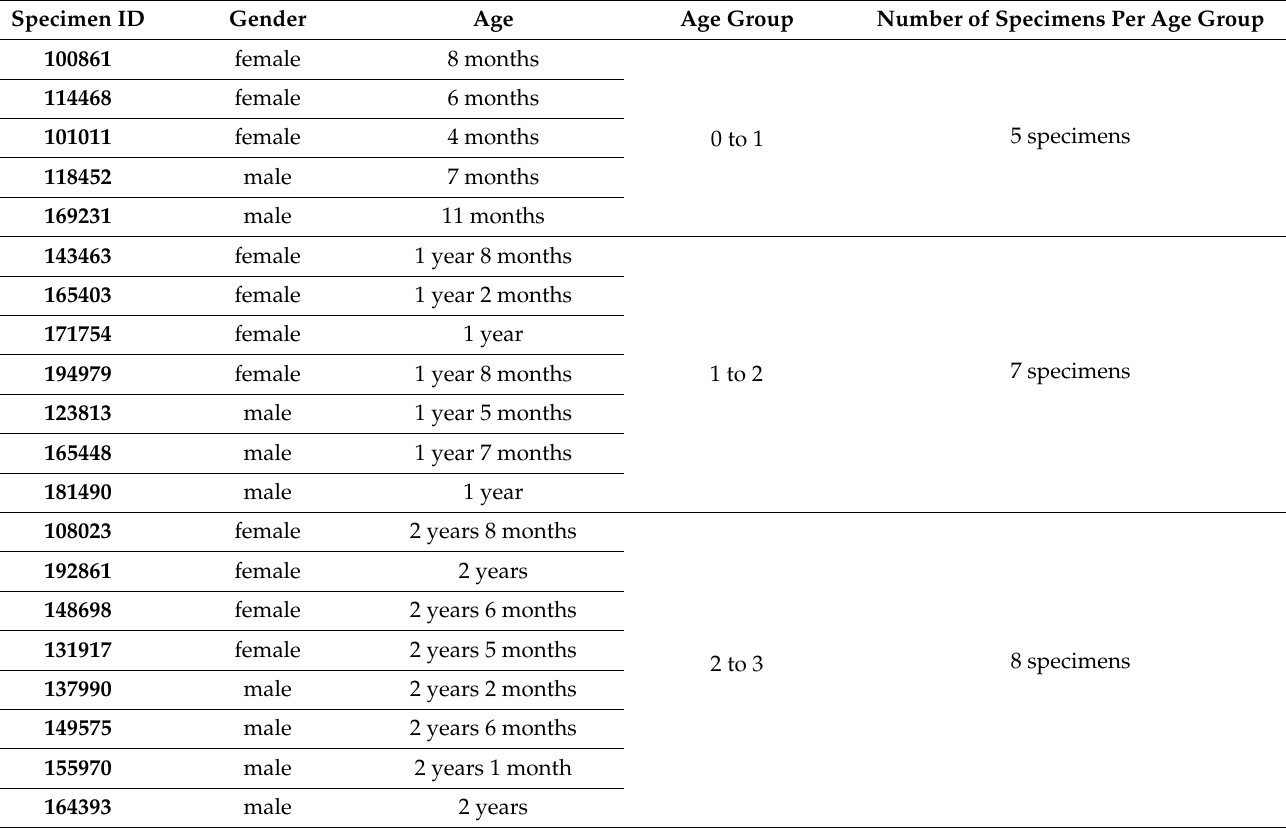
Table A1. Specimen Details: ID, Gender, Age, Age Group, and Number of Specimens Per Age